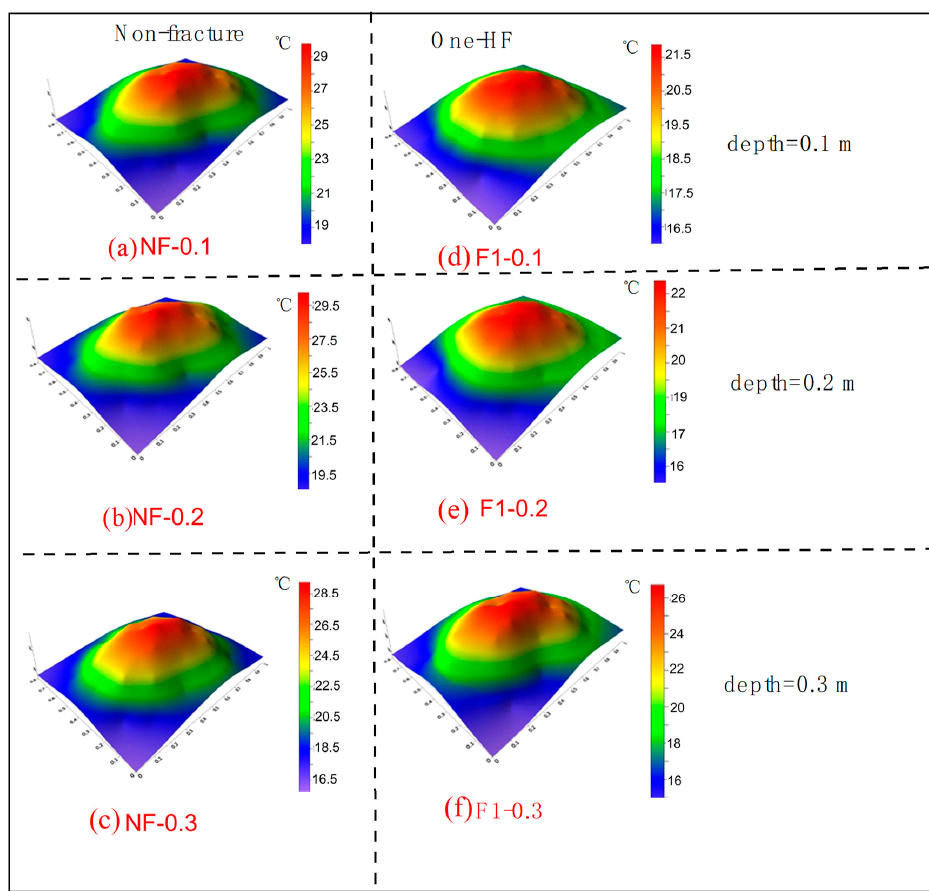
Figure 4. Plane temperature distribution of the rock mass at depths of 0.1 m, 0.2 m, and 0.3 m: the left column is a rock mass without a fracture (NF); the right column is rock mass with one horizontal fracture (F1), and the rows correspond to different depths. Figure 5A,B are the curves of instantaneous temperature at the center of the rock mass by the end of the simulated cooling period. They were measured at the depths of 0.1 m, 0.2 m, and 0.3 m, respectively. The measured temperatures in the model with a hori- zontal fracture were lower than that in the non-fracture rock mass all the time. Meanwhile, the slope temperature curves of the horizontal single fracture rock mass monitoring hole were gentler than those of the non-fracture rock mass, indicating that the temperature increased more slowly due to the improved heat capacity of the rock mass brought by the fracture water.